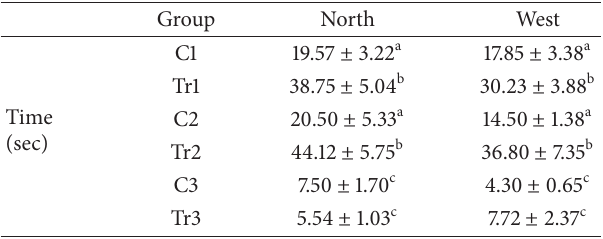
Table 2: Average latency to reach the hidden platform from the north and west starting points for control (C1, 𝑛 = 18 ), (C2, 𝑛 = 10 ), and (C3, 𝑛 = 7 ) and treated (Tr1, 𝑛 = 18 ), (Tr2, 𝑛 = 10 ), and (Tr3, 𝑛 = 11 ) rats by the 4th learning day in the Morris water maze. Data are shown as mean values ± SEM. Values not sharing the same letter are significantly different; 𝑃 < 0.01